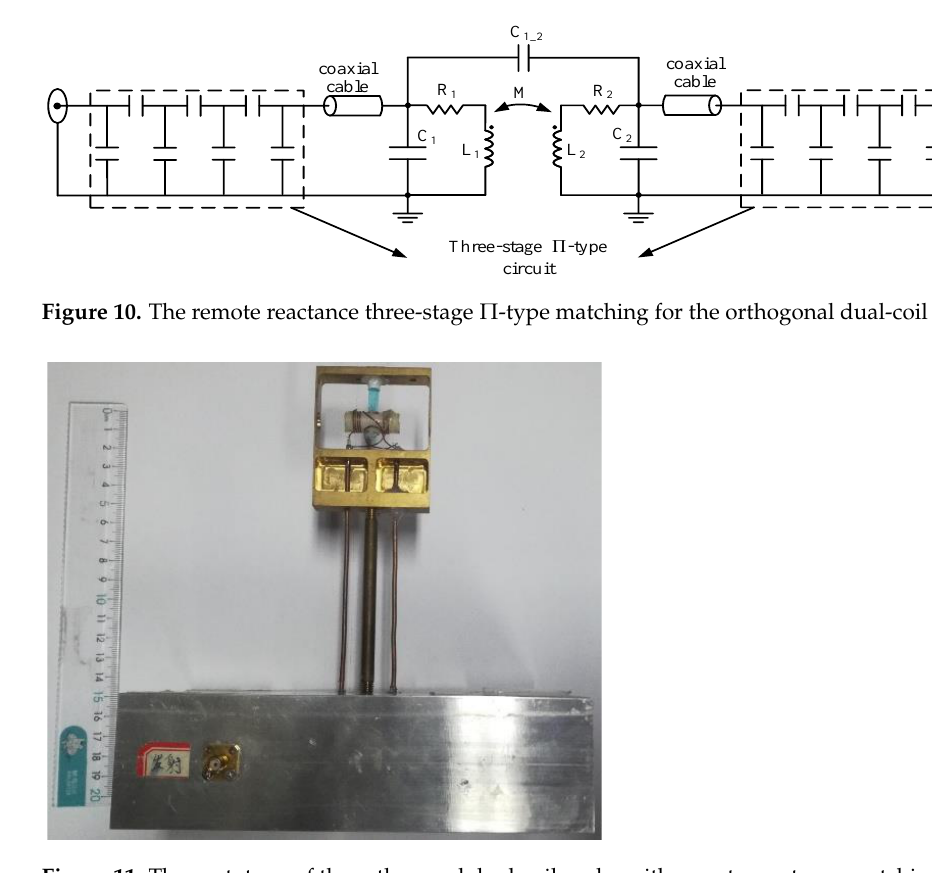
Figure 11. The prototype of the orthogonal dual-coil probe with remote reactance matching circuits.